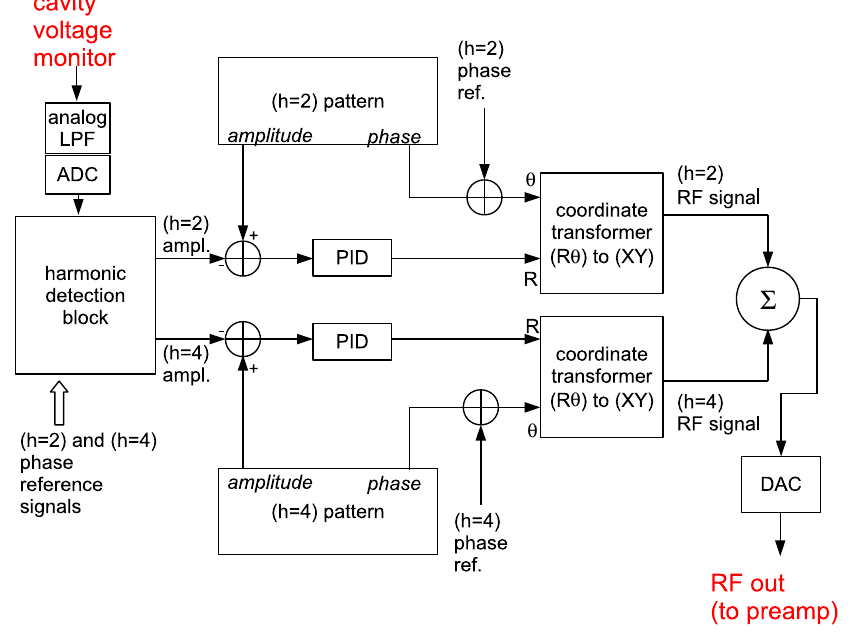
FIG. 6. (Color) Block diagram of the dual-harmonic AVC.